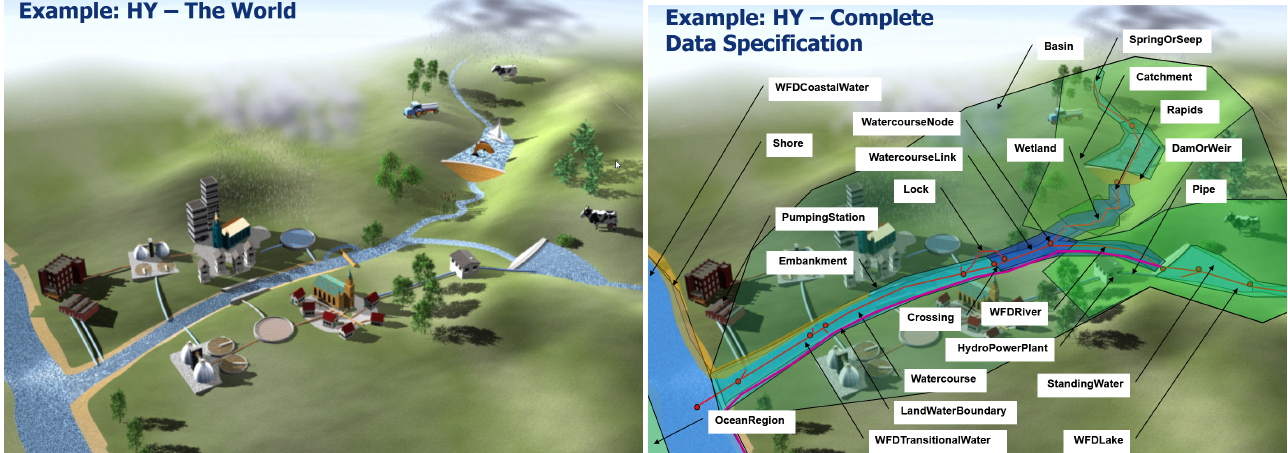
Figure 3. Abstraction of the real world in INSPIRE. Example from the “hydrography” data theme. Source: INSPIRE hydrography data Specification (figure source